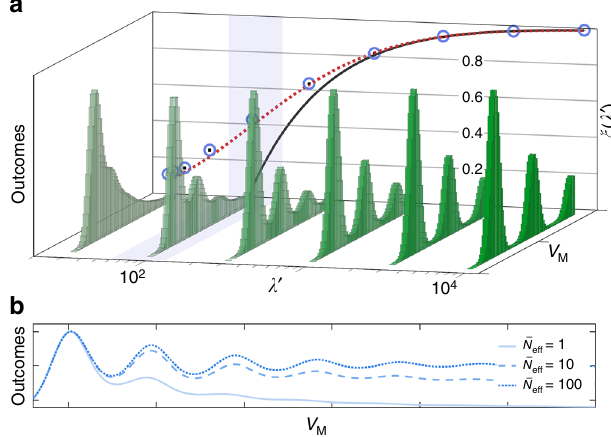
Fig. 5 Visibility of the phonon QND measurement. a 3D plot: histograms of outcomes for different λ ′ (from left to right, λ ′ = 32, 10 2 , 3 × 10 2 , 10 3 , 3 × 10 3 and 10 4 ). The optimal values of Δ n b are (from left to right) 0.43, 0.27, 0.12, 0.05, 2 × 10 − 3 and 8 × 10 − 4 , and have been determined by a numerical optimization. The shadowed region corresponds to the estimated visibility for state-of-the-art technology, λ ≃ 60 – 130. 2D plot (back): maximum visibility ξ for different values of the parameter λ ′ . The blue circles have been evaluated numerically from the histograms in the 3D plot (and others). The error bars of the Monte Carlo simulation (black lines inside) have been determined assuming Poissonian statistics in each bin, and are negligible on this scale. The red dotted curve comes from our model for the visibility, and the black solid curve is the simpli fi ed expression ¼ 1. See Methods for more details. presented in Eq. (10). We consider (cid:2) N eff being 1 (full), 10 (dashed) and b Expected outcomes for λ ′ = 75 and (cid:2) N eff 100 (dotted line). The parameter Δ n b has been optimized to achieve maximum visibility for each value of (cid:2) N